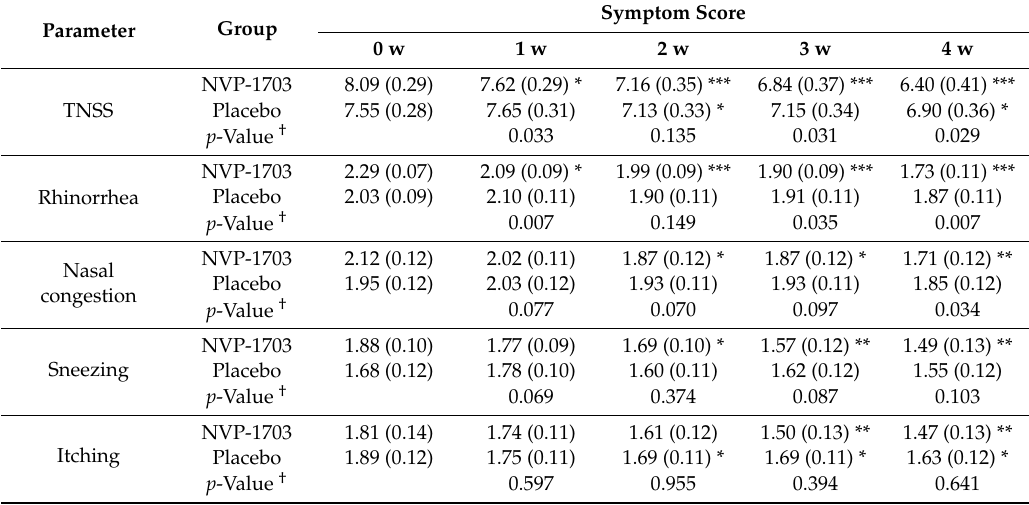
Table 2. Changes in TNSS and individual symptom scores during the study